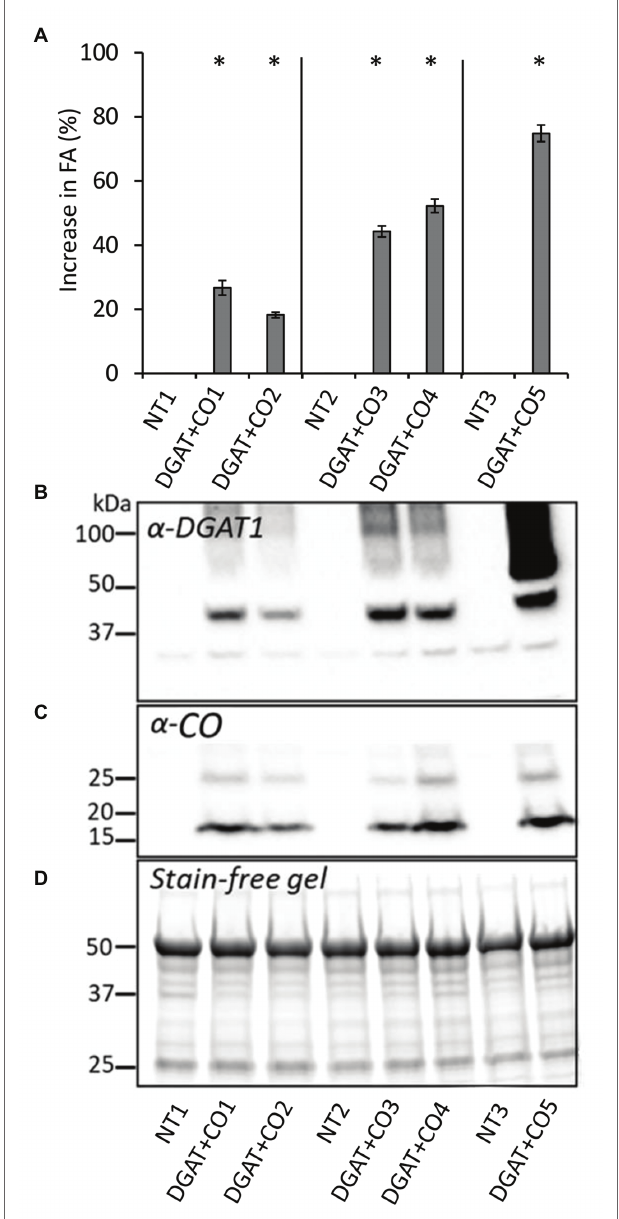
FIGURE 1 | Percent difference (±SE) in leaf fatty acids compared to respective NT (A) , recombinant protein contents for diacylglycerol acyl-transferase (DGAT; B ) and cysteine-oleosin (C) , and stain free gel showing equal protein loading for each cell (D) , for five DGAT + CO lines and three respective NT controls. Matching genetic backgrounds are grouped together. * p <